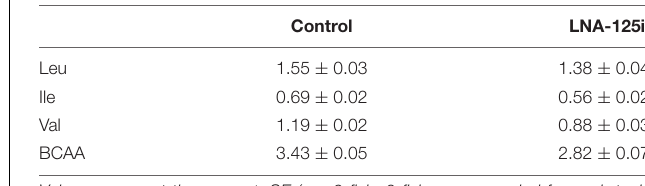
TABLE 3 | Effect of injection with LNA-125i on BCAA content in the skeletal muscle of Nile tilapia (g/100